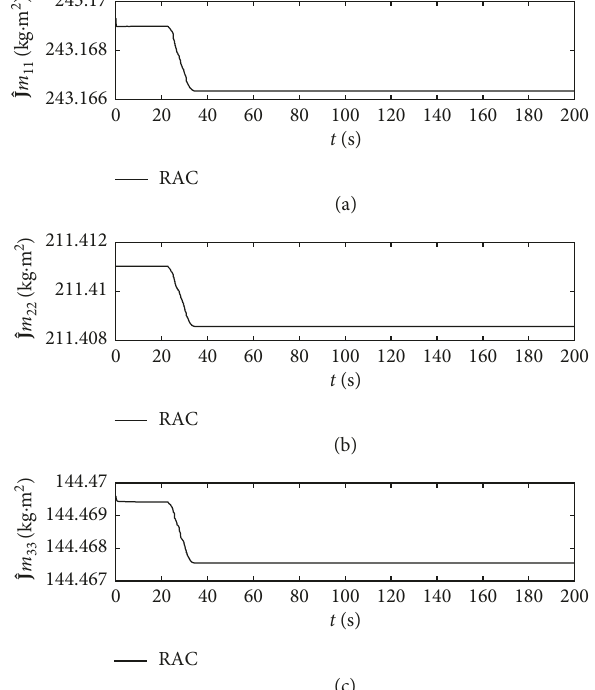
Figure 9: Time response of estimated parameters of inertia in Case